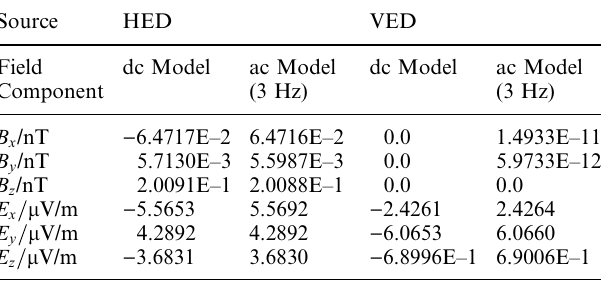
Table 7. Validation of dc model against the ac model (layer